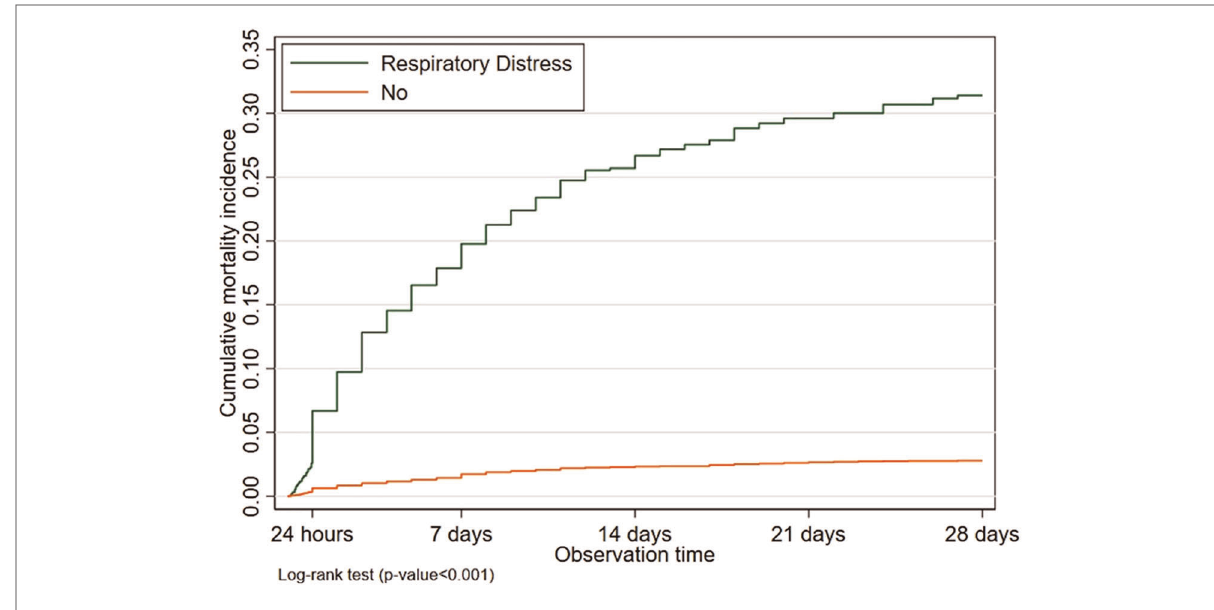
FIGURE 3 Cumulative mortality incidence of newborns with respiratory distress compared with absence of respiratory distress in neonatal period.